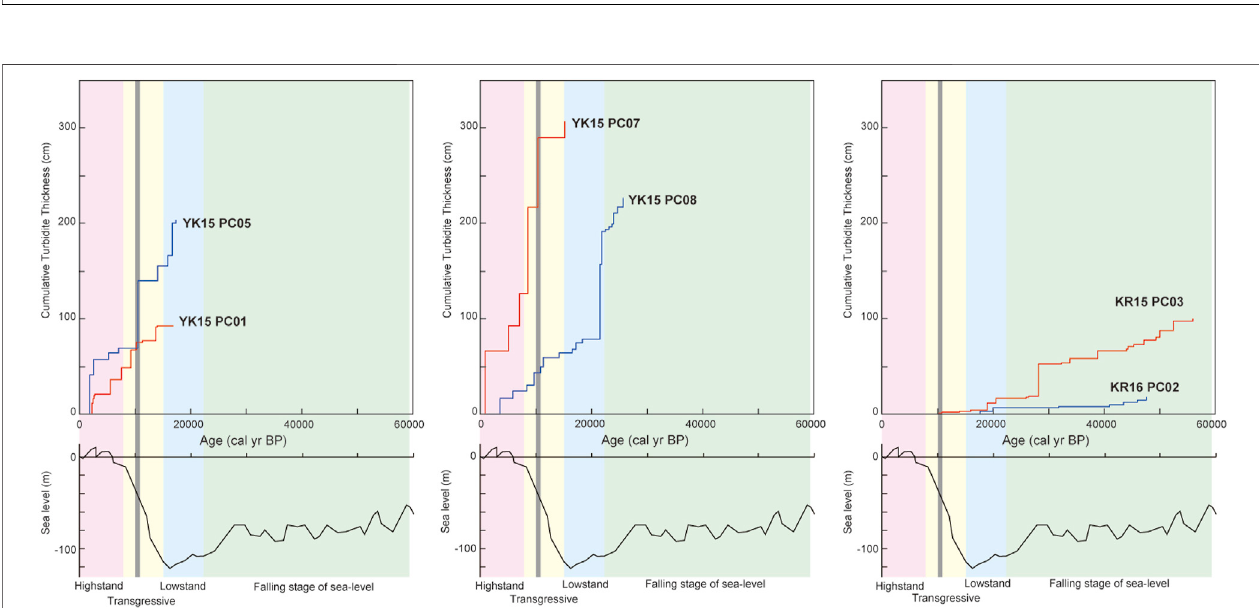
FIGURE3| Ratiosofcoralreef – shallowwater – mid-deepwaterbenthicforaminiferalspeciesincalciturbidite(T)andhemipelagicmuds(H)ofcoresYK15PC01and PC08.